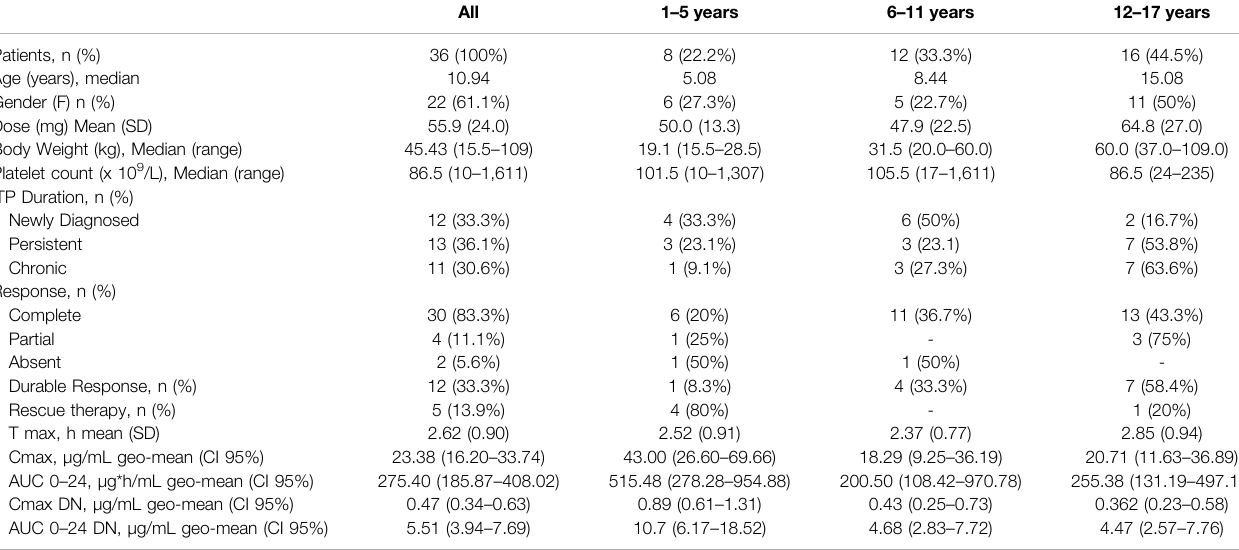
TABLE 1 | Patients ’ characteristics at the time of the study visit and estimated pharmacokinetic parameters.